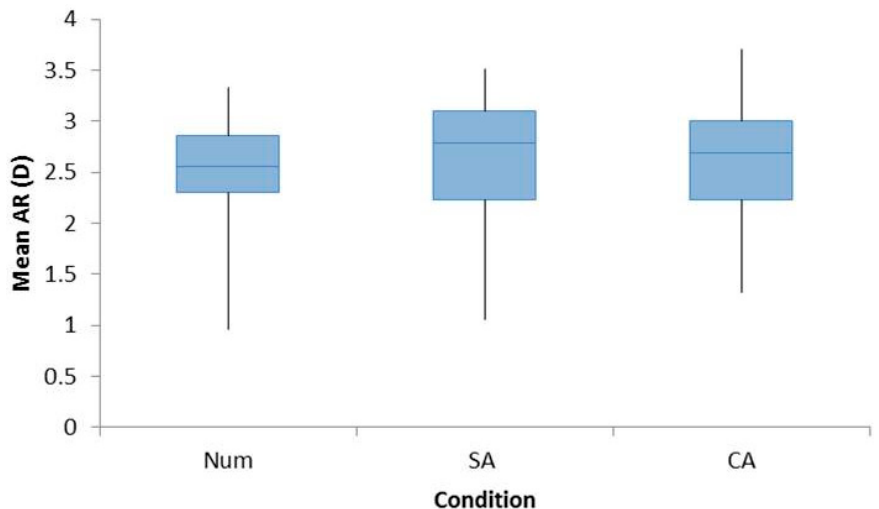
Figure 1. Box plots demonstrating the increase in the accommodative response from baseline distance readings for all participants for the conditions Num, SA, and CA. A repeated measures ANOVA with Bonferroni post-hoc analysis found no significant differences across the three conditions.